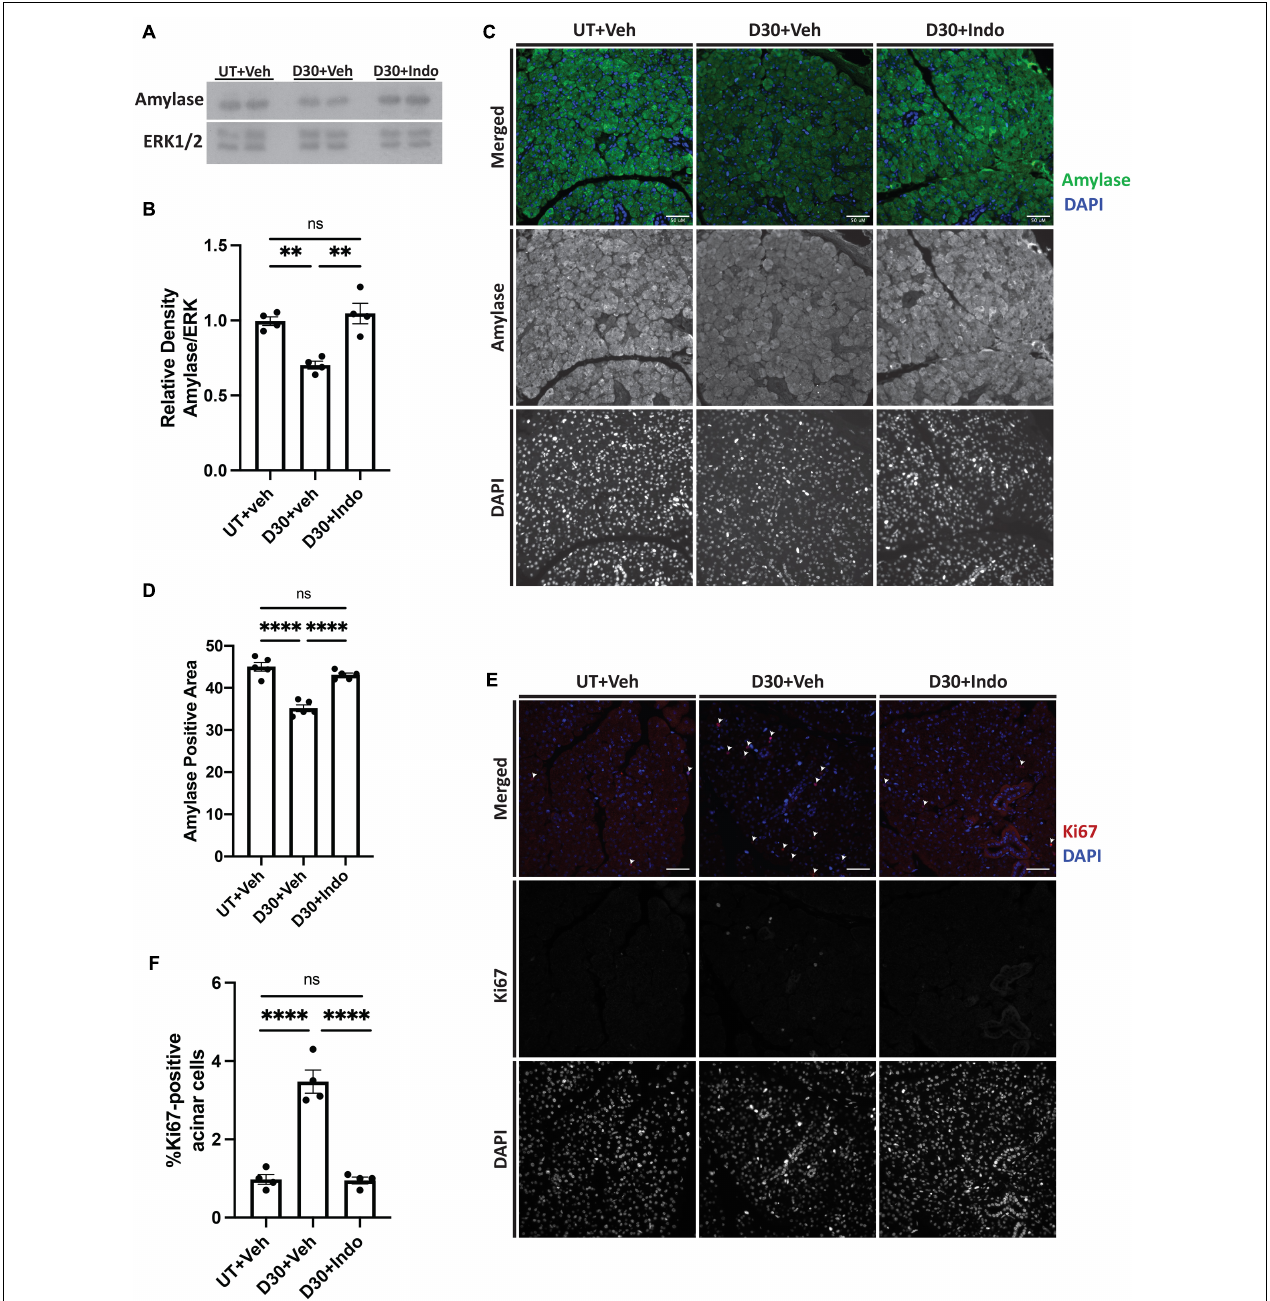
FIGURE 7 | Indomethacin treatment enhances amylase levels and reduces compensatory proliferation in whole parotid glands at day 30 post-IR. (A,B) C57BL/6J or (C-F) FVB mice were untreated (UT) or received 5 Gy ionizing radiation (IR) with intraperitoneal injections of vehicle (Veh, saline with 10% ethanol) or indomethacin (Indo, 1 mg/kg body weight) at days 3, 5, and 7 post-IR. Parotid glands were extracted at day 30 post-IR. (A,B) Immunoblots were generated from tissue lysates and an anti-amylase antibody, which were stripped and re-probed for ERK1/2 as a loading control. (A) Representative Western blot images of changes in amylase levels following radiation and indomethacin treatments. (B) Densitometry was performed using ImageJ software and protein content was normalized to the average of the UT + Veh group. (C–F) Parotid glands were fixed, sectioned and immunohistochemistry was performed with (C,D) an anti-amylase antibody or (E,F) an anti-Ki67 antibody, as described in section “Materials and Methods.” (C) Representative images of amylase positive area (40 × magnification, scale bar: 50 µ m). (D) Percent positive amylase area was determined using ImageJ software. The graph represents the amylase positive area as a percentage of the total area. (E) Representative images of Ki67 positive area (white arrows indicate Ki67+, DAPI+ cells; 40 × magnification, scale bar: 50 µ m). (F) Ki67 positive and total cell numbers were manually counted from 5 fields of view/mouse. The graph represents the Ki67 positive cell number as a percentage of the total cell number. (B,D,F) Graphs represent the mean ± SEM. Each closed circle represents an independent sample. Significant differences were determined via a one-way ANOVA followed by Bonferroni’s post hoc comparisons (** p < 0.01, **** p < 0.0001; ns = not significant).